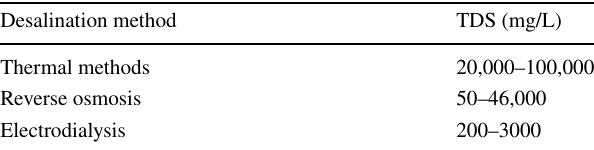
Table 5 The function of each desalination method based on the TDS of inlet